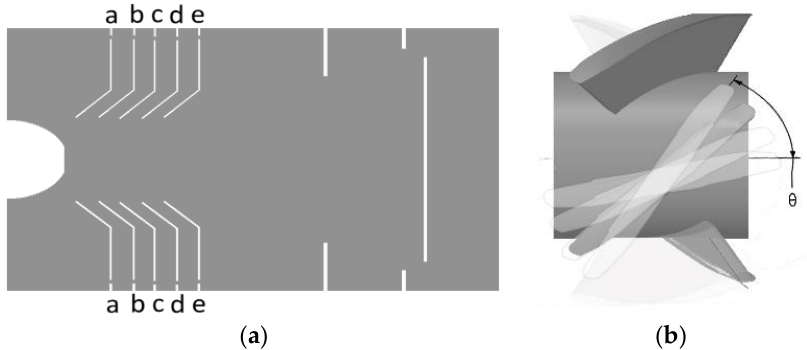
Figure 8. Burner design optimization: ( a ) cases for relocating ring cone (location c is the same as the baseline case C); ( b ) changing the air inlet swirl velocity (vane angle in the experimental case was 45°).